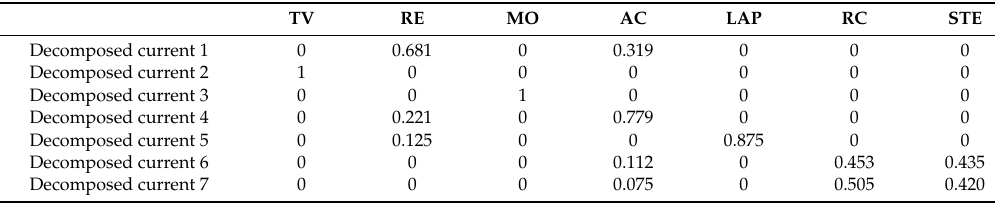
Table 5. Initial load identification of the second